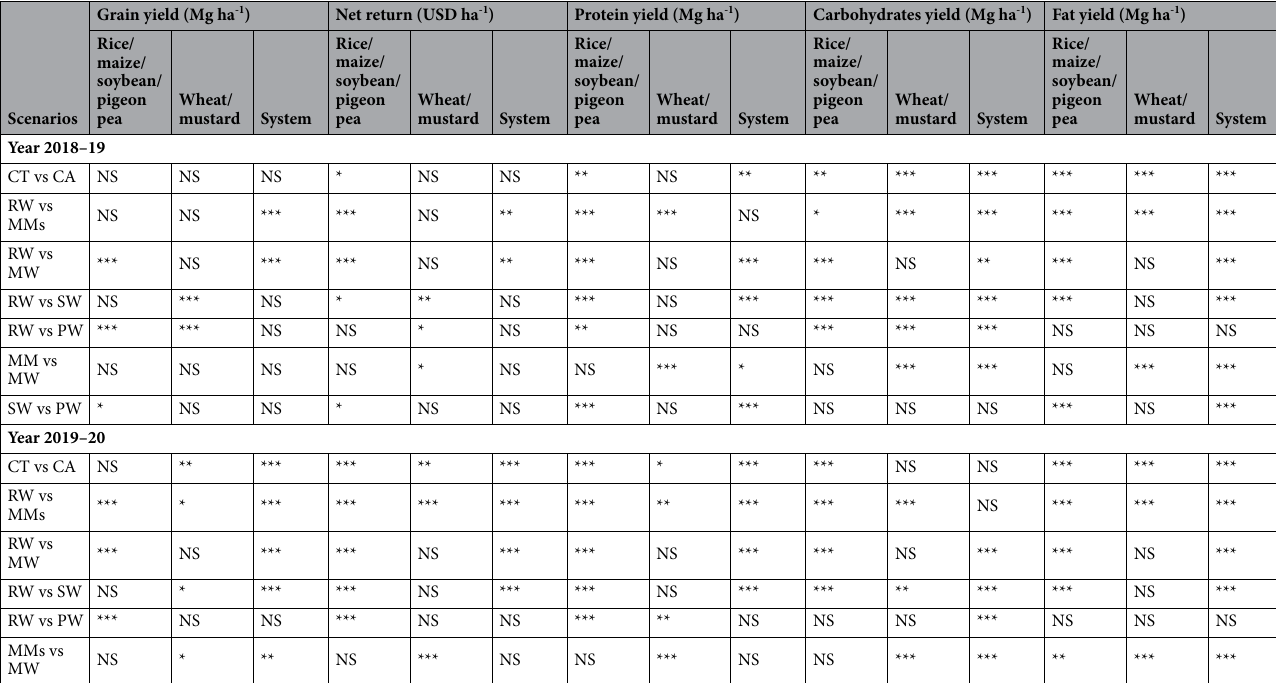
Table 3. Significance effects of different agronomic management practices and their linear contrast on grain yield, net return, protein yield, carbohydrate yield and fate yield under different scenarios during 2018–19